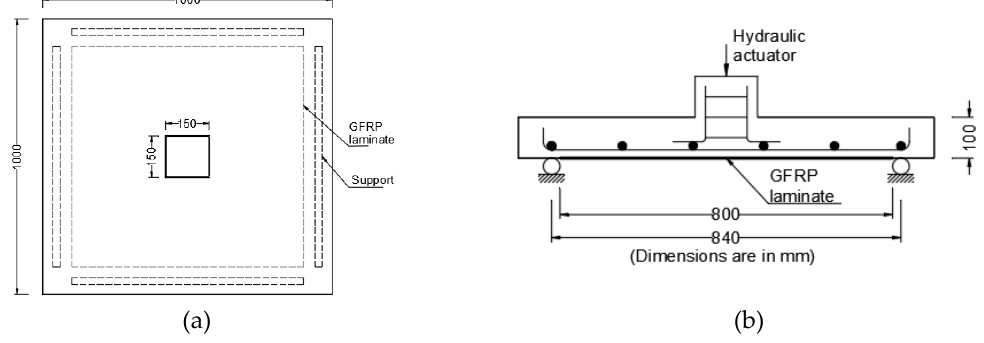
Figure 4. GFRP laminate applied to tension side of 1000 mm × 1000 mm specimen, ( a ) specimen and loading column dimension and ( b ) loading applied causing tension at the bottom with GFRP [29].